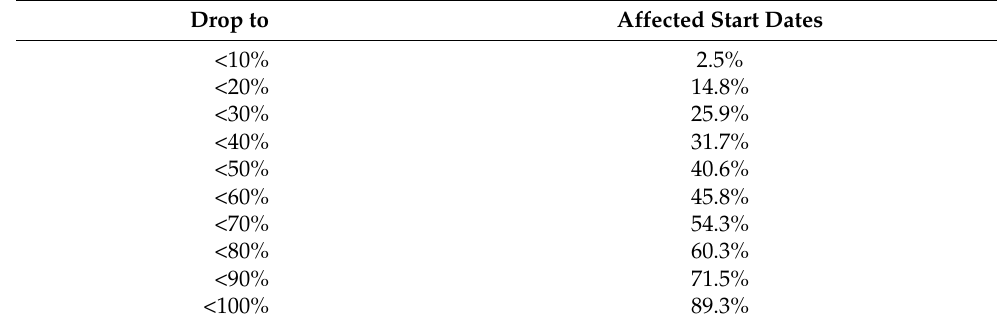
Table 5. Affected starting dates after which the Ethereum price drops below a certain percentage of the given day’s price between January 2017 and April